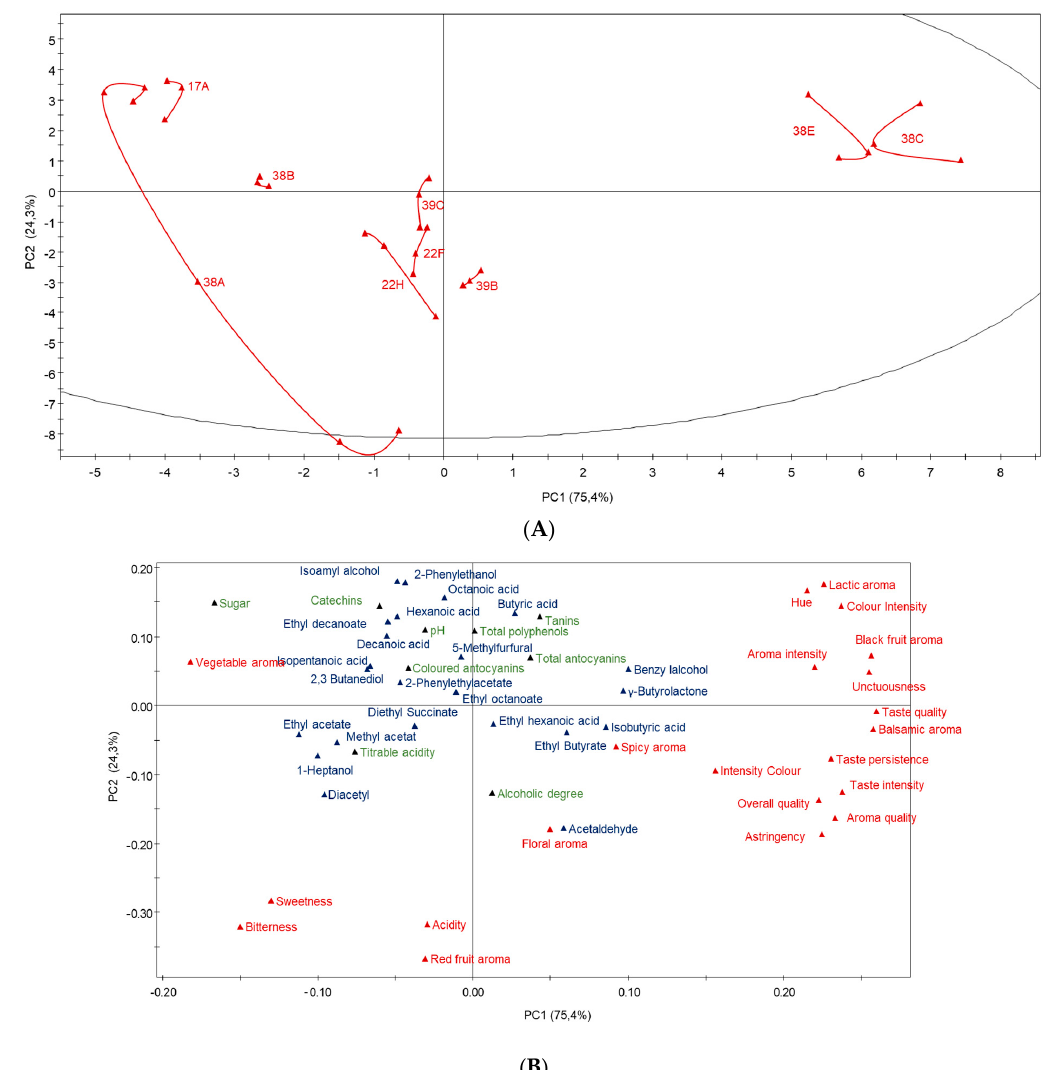
Figure 4. ( A ) Score plot and ( B ) loading plot on principal components PC1 and PC2